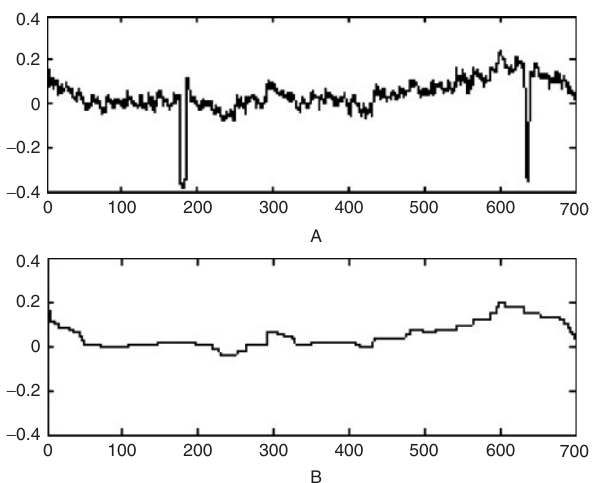
Figure 23 Experimental study with subjects 1, 2 and 3 (from top to bottom).